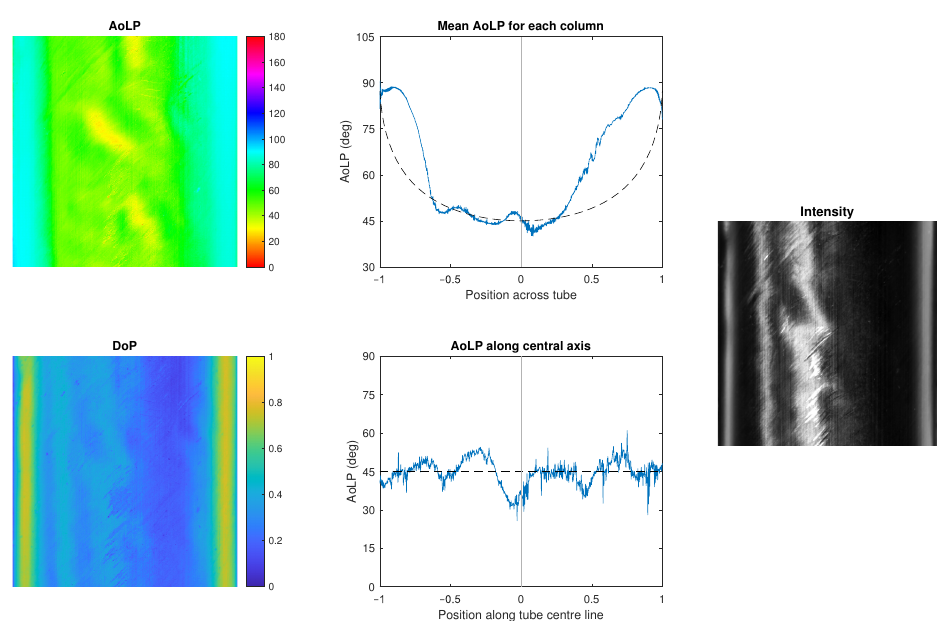
Figure 25. Recovered data for the UD cured tube under ambient illumination in a similar format to the case of Figure 23.